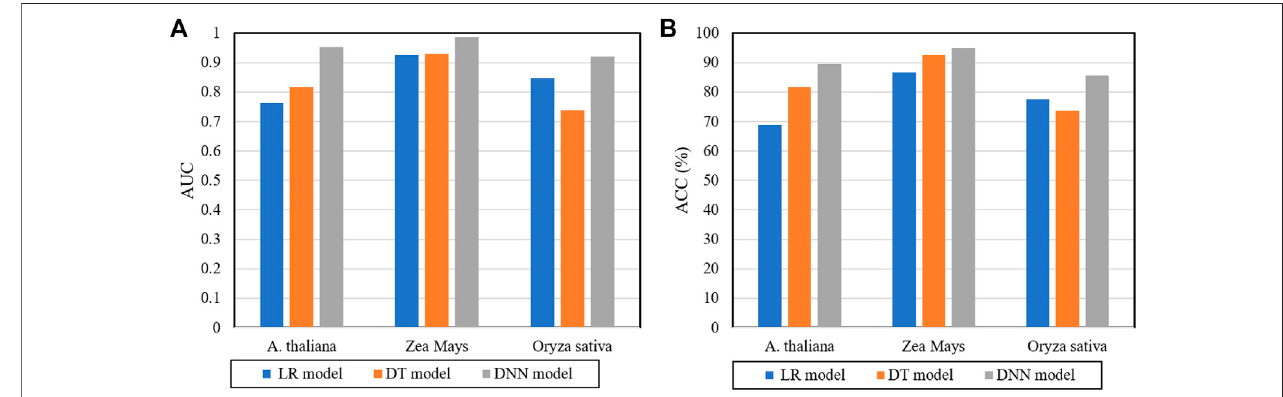
FIGURE 4 | Comparison results of different classi fi ers with the DWPPI model (A) is the predicted AUC values of different classi fi ers on three plants PPIs datasets. (B) is the predicted ACC values of different classi fi ers on the three plants PPIs datasets.